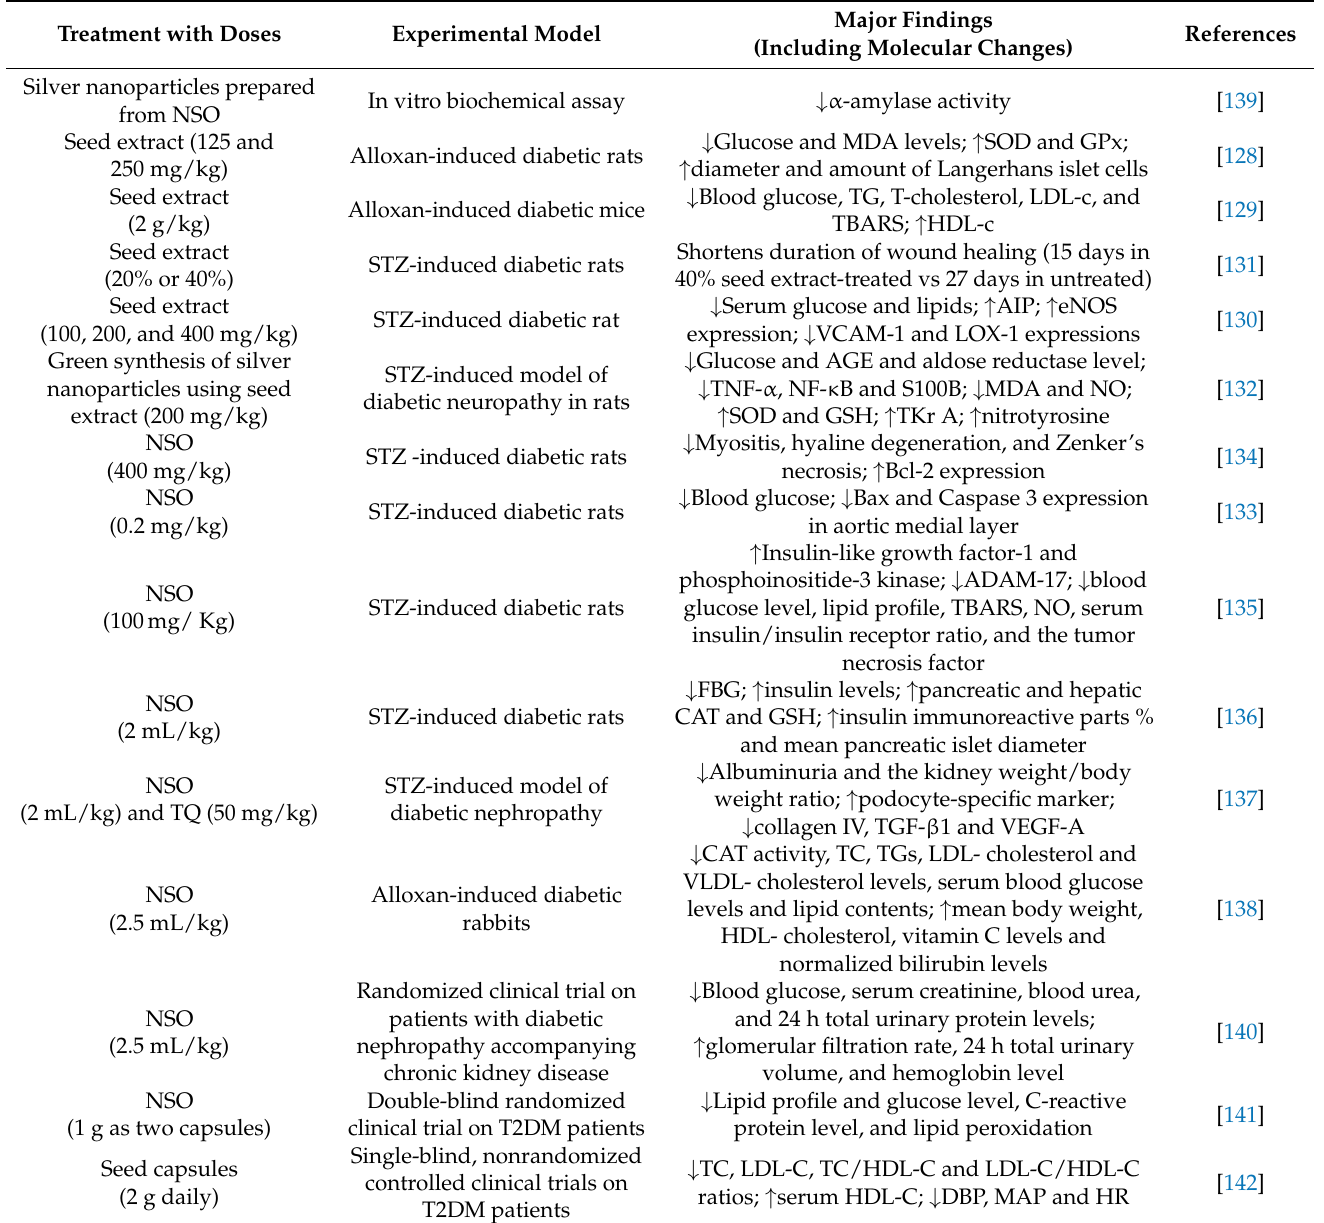
Table 4. Comprehensive summary on the antidiabetic effects of black